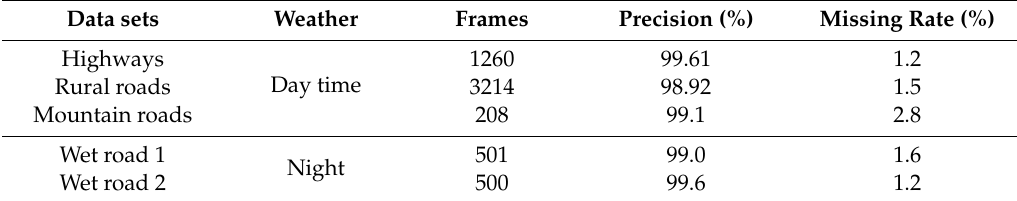
Table 3. Detection results of the seed algorithm using other data sets. Figure 16. Other typical road environments.